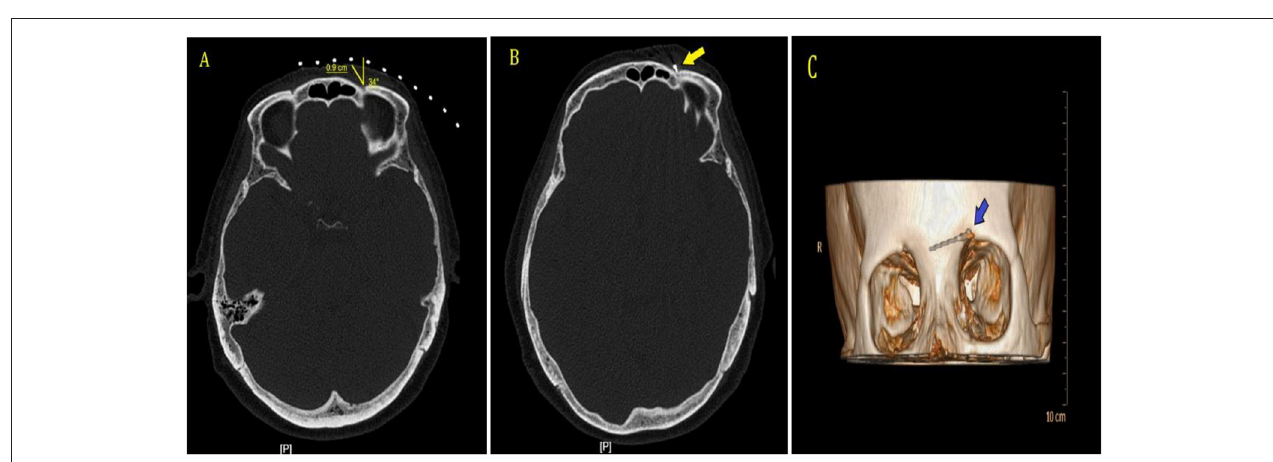
FIGURE 1 | Flowchart of the study. Fifty-two patients were randomized to C group ( n = 26) and H group ( n = 26).